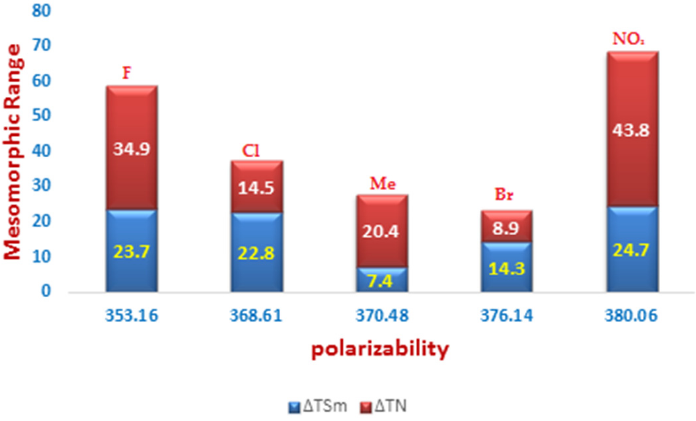
Figure 7. Dependence of the mesomorphic range with the calculated polarizability.